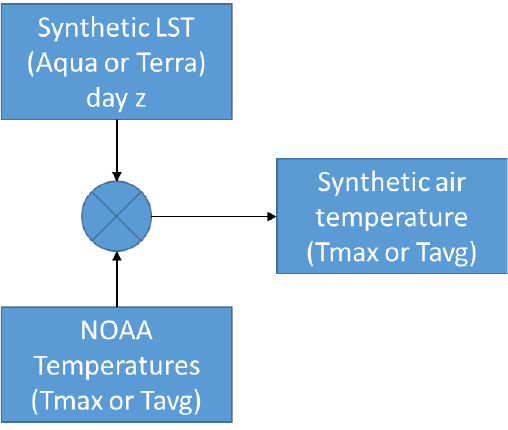
Figure 4. Flowchart—step 4—conversion of synthetic LST to air temperature.